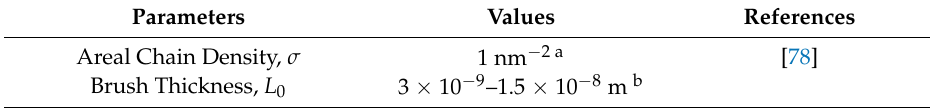
Figure 3. The interaction energy profiles for DLVO including the depletion and steric interaction are represented with variations in the brush thickness (3 × 10 − 9 –1.5 × 10 − 8 m) as a function of the separation. The values of the silica-bubble-water Hamaker constant ( − 3.12 × 10 − 21 J), ionic strengths (20 mM), silica surface potential ( − 0.02 V at pH 7), bubble surface potential ( − 0.025 V at pH 7), polymer weight (10 wt %), polymer volume fraction (8.84 × 10 − 1 ( v / v )), polymer radius of gyration (6.48 × 10 − 9 m), polymer molecular weights (10 4 g/mol) and areal chain density (1 nm − 2 ) are fixed. Table 4. Parameter values of steric interaction employed in the theoretical